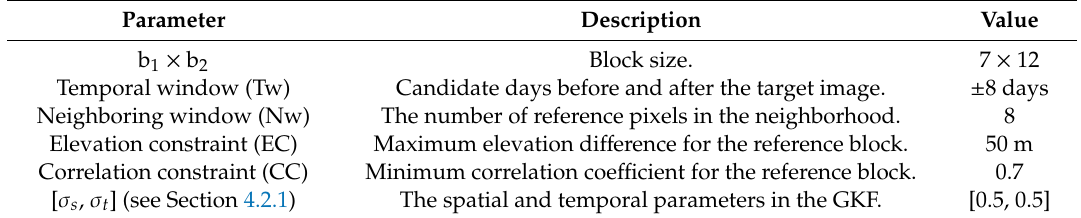
Table 2. The parameters in the Gaussian kernel function (GKF)-based weighting integration of the spatio–temporal